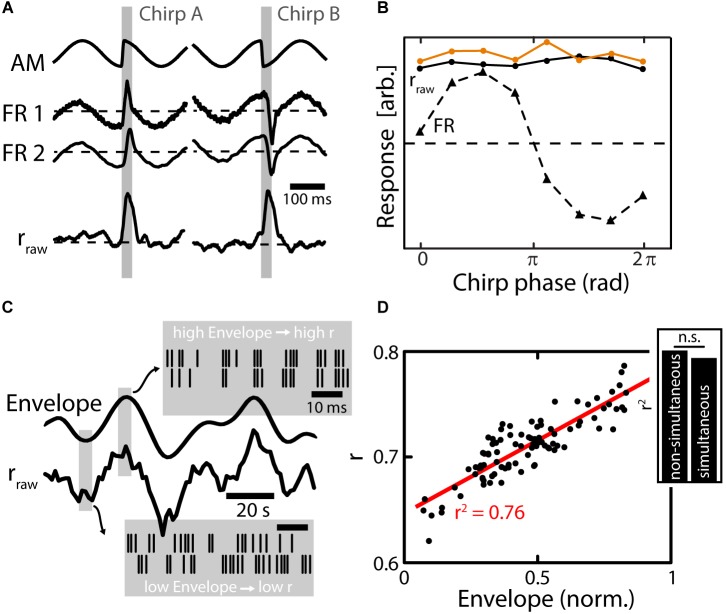
Population coding of electrosensory afferents. (A) Top: Stimulus waveforms (gray shading) resulting from chirps with a fixed ΔT and ΔF emitted during different phases of the AM (EOD not shown). The waveform of the chirp on the left consists of a sharp increase of the AM, while it is a sharp decrease for the chirp on the right. The social meaning of these chirps, however, is exactly the same as established in behavioral experiments. Middle: Firing rate responses of simultaneously recorded EAs. EAs encode the waveform of the AM faithfully, which results in very heterogeneous response waveforms between the two different chirps (compare left and right). Bottom: The time varying correlations between EAs increase during the chirp event. The increase in the correlation coefficient is similar between different chirps (left vs right). (B) Quantification of responses to chirps of different phases. Responses are very heterogeneous for the different chirp phases based on firing rate (FR, triangles and dotted line) while responses are invariant based on correlations (rraw dots and solid black line). Importantly, behavioral responses were also invariant (orange dots and solid line) implying that correlations can better predict behavior than the single neuron firing rate. (C) Envelope signal (solid line on top) and time varying correlation coefficient (rraw) of two EAs. During low envelope amplitudes, the firing of EAs is heterogeneous (see raster plots in lower gray window) while during high envelope amplitudes firing is more similar between EAs (see upper gray window). The changes in correlation coefficients closely track the envelope signal (compare two solid black traces). (D) The relationship of correlation coefficients and envelope amplitude is linear and strong (for the shown example r2 = 0.76). Inset: similar results were obtained when using simultaneous and non-simultaneous recordings of EAs suggesting that noise correlations are of little relevance for signal encoding at the stage of afferents. Data in (A,B) from (Metzen et al., 2016a), in (C,D) from (Metzen et al., 2015b).